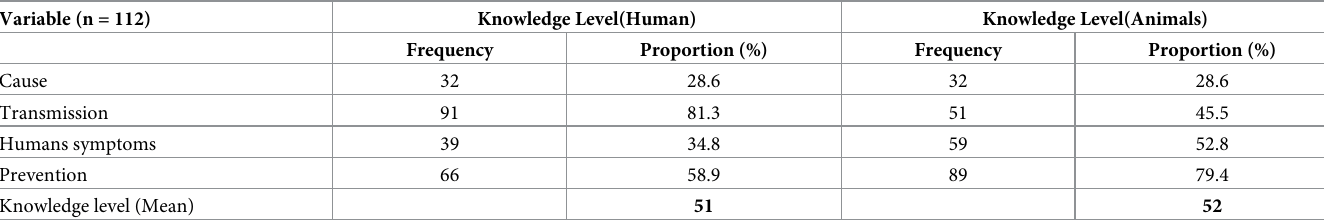
Table 3. Knowledge level for human and animal anthrax, Kisumu east Sub County, July